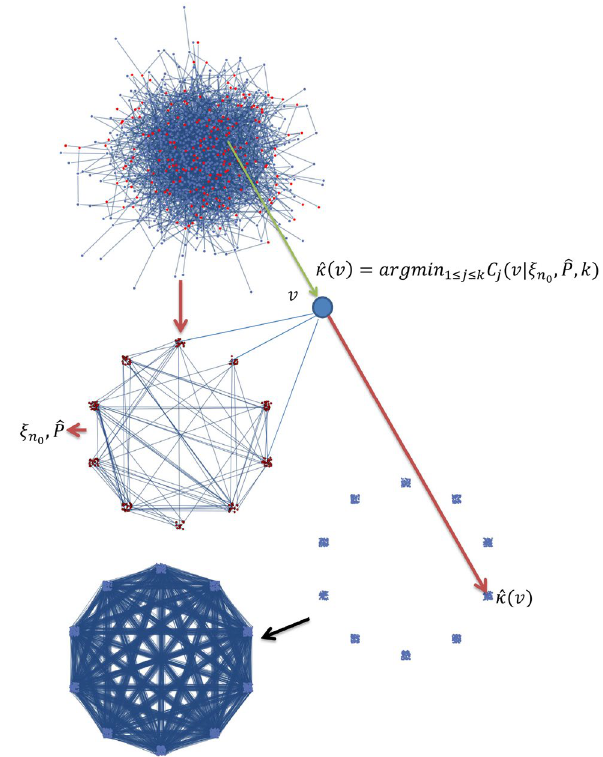
Fig. 8 A scheme of RD for a huge graph shown at the top; in real- ity, we assume a much larger graph than what is shown in the pic- n ture. First, a moderate size sample of 0 nodes and induced subgraph ̂ P ̂𝜉 is formed. RD is applied to this small graph; groups n 0 and matrix are found, shown as the graph in the middle. Then, sequentially, any node v from the big graph can be classified to a regular group using just counts of links of this chosen node to regular groups of the sam- ple graph. This classification requires a constant number of computa- k 2 n tions, upper-bounded by 0 , with elementary functions. As a result, nodes of the whole graph can be classified in just linear time with respect to number of nodes. After the classification is done (shown in the ring shape structure at the right side) the RD of the large graph is done simply by retrieving link information. The result is shown in the lower